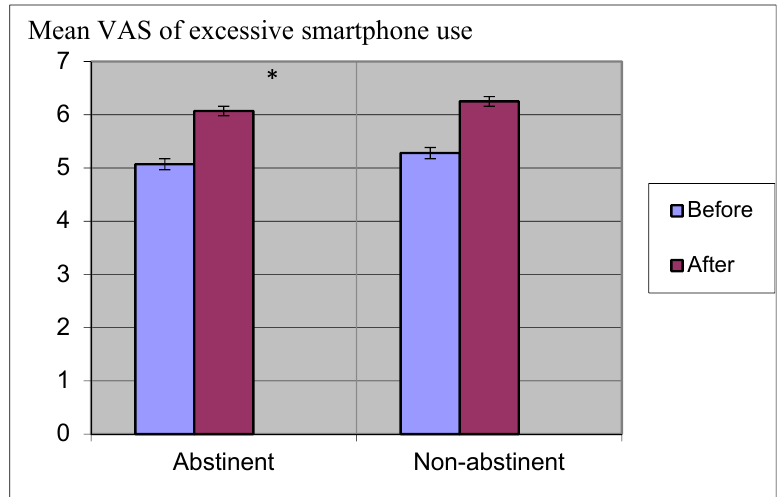
Figure 2. Ratings of the smartphone addiction (VAS short) questionnaire before and after abstinence in the abstinent group compared with the non-abstinent control group. * p < 0.05.